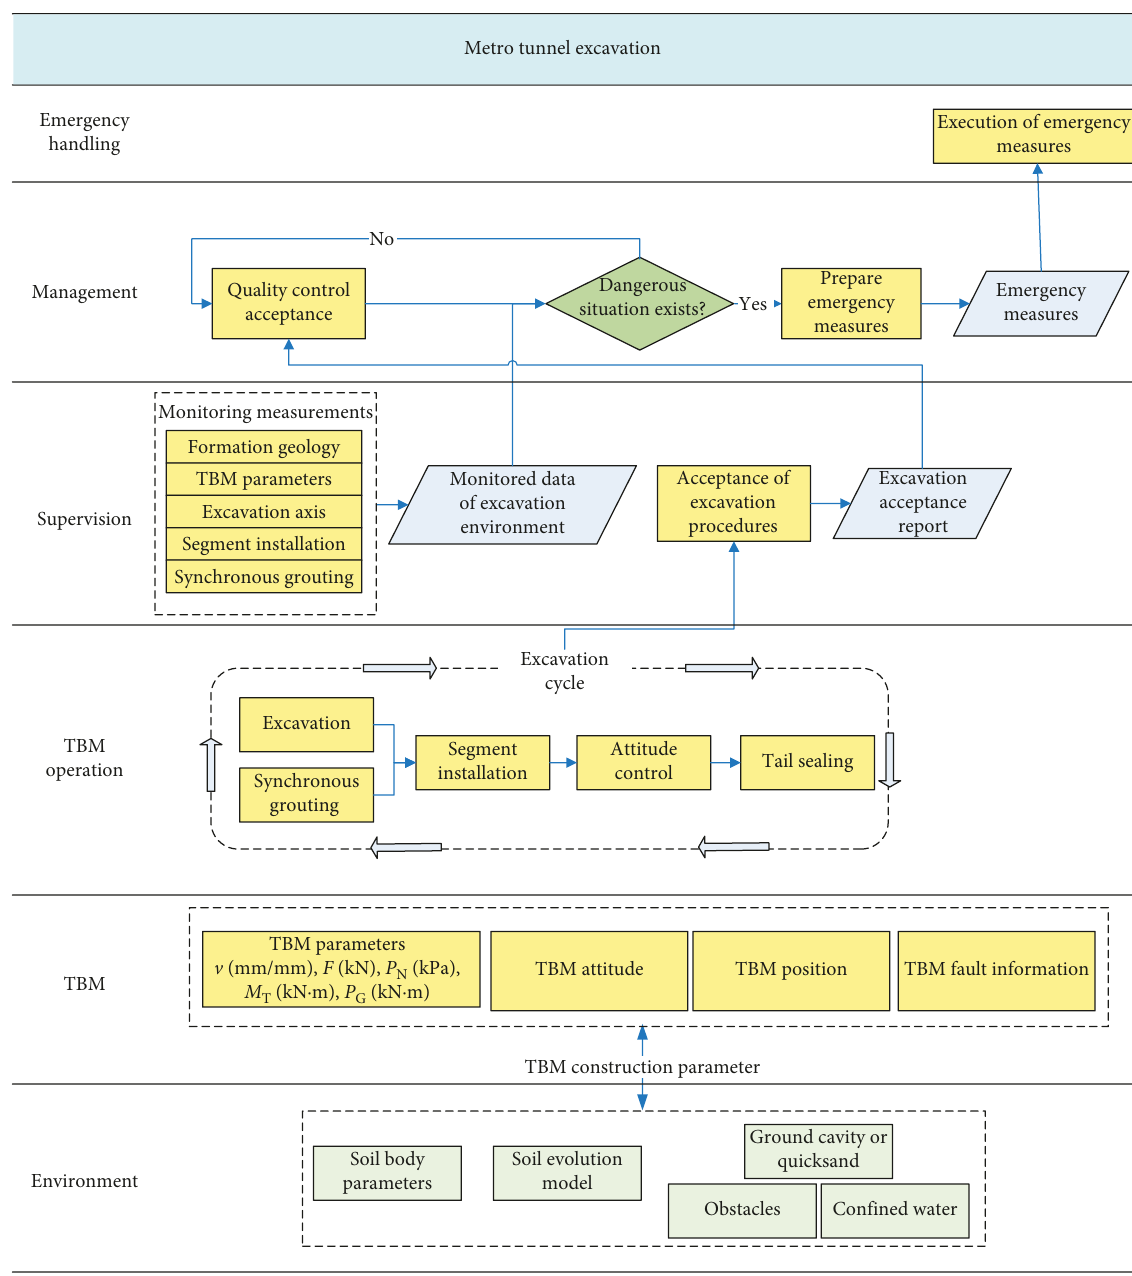
Figure 8: System diagram of the “normal excavation